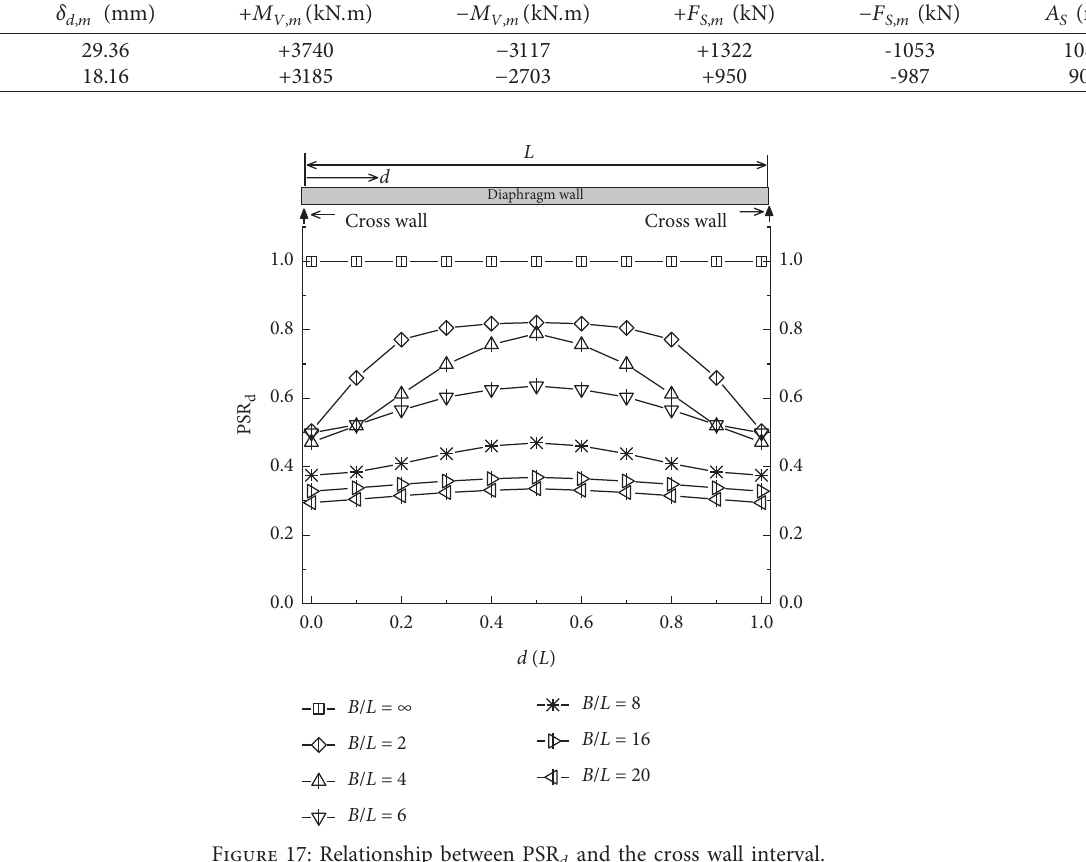
d and the cross wall